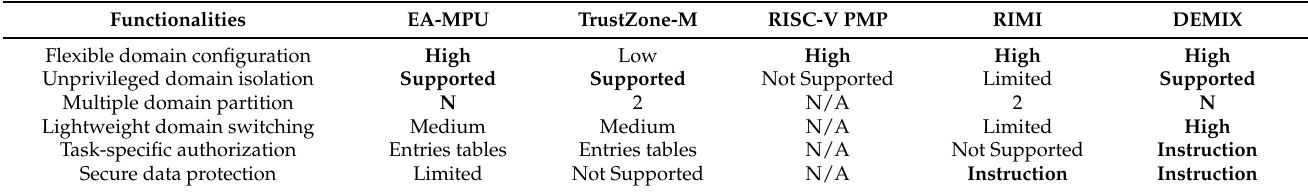
Table 3. Detailed functionality comparison with existing MPU-based